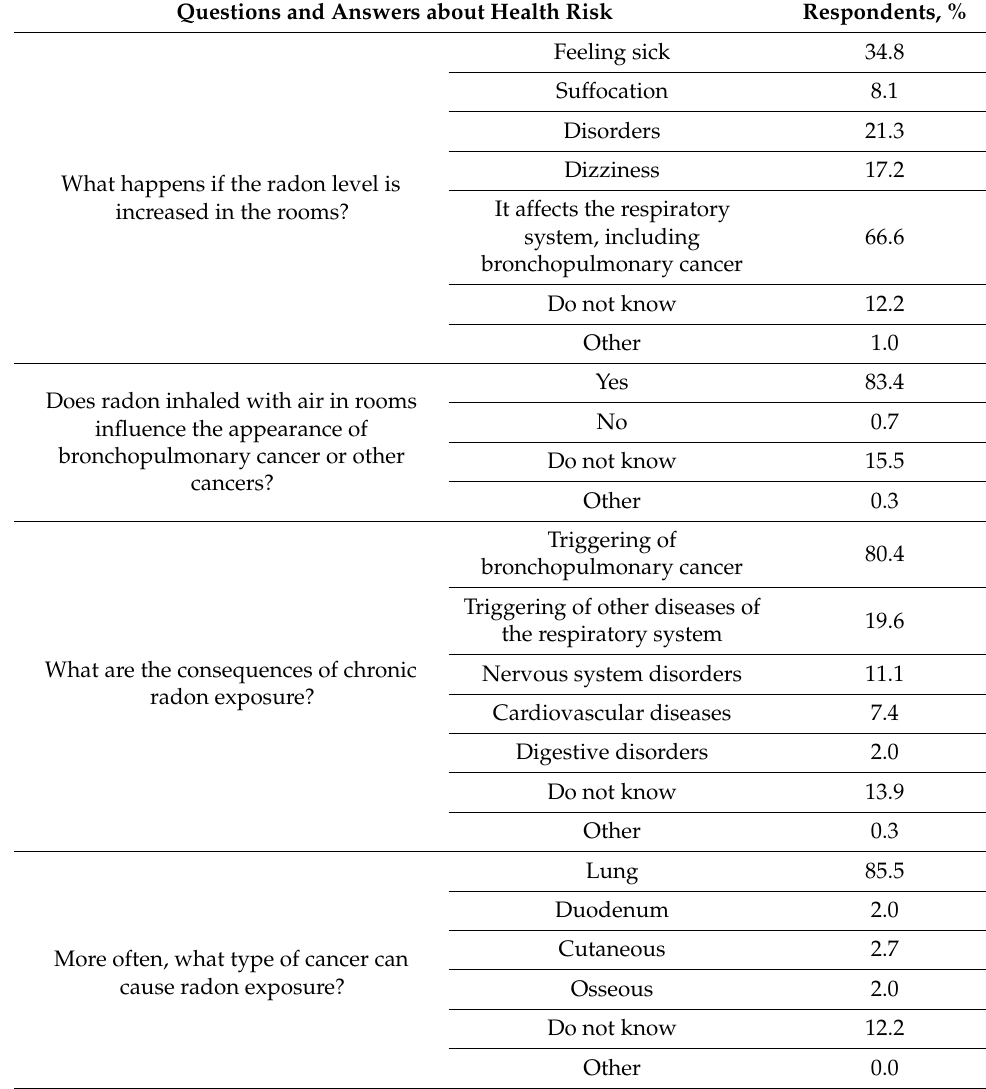
Table 1. Questionnaire regarding the health risk as a result of radon exposure used in the Republic of